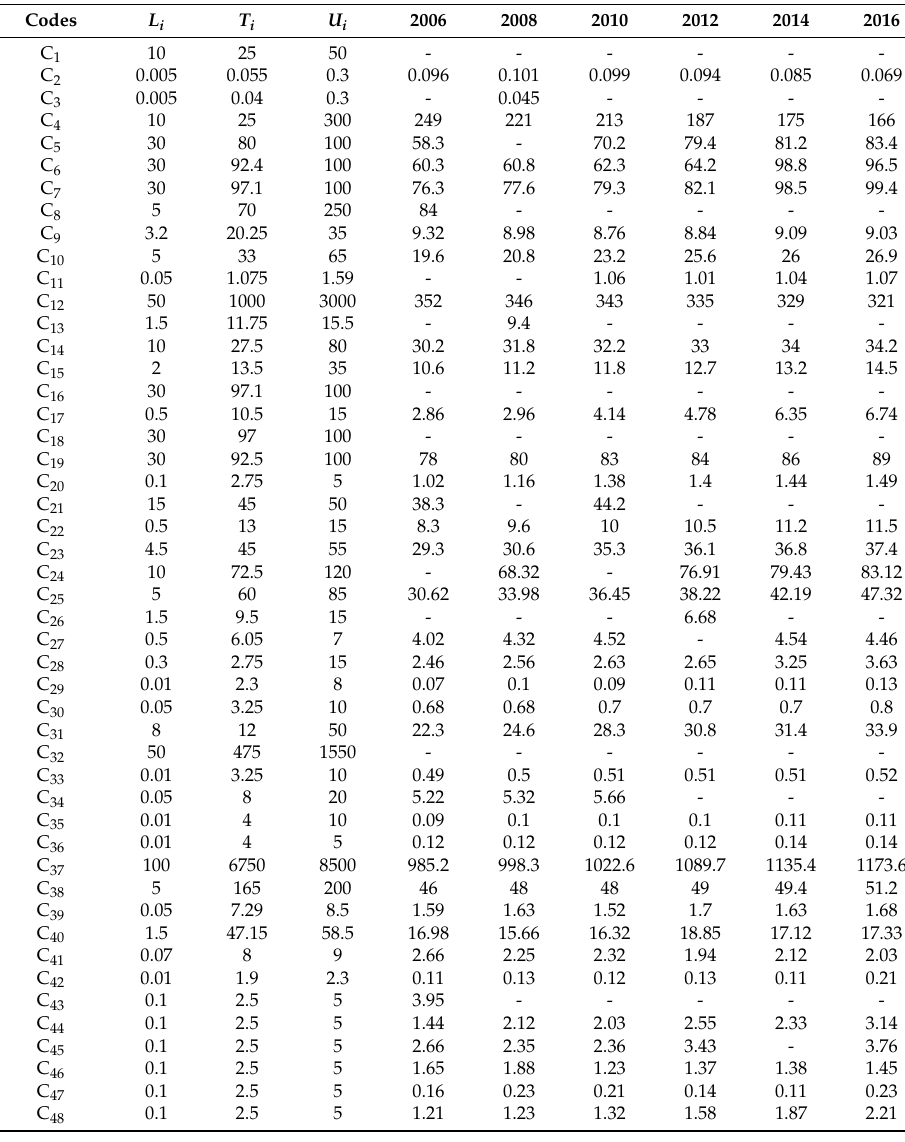
Table A3. Parameters of dynamic evaluation